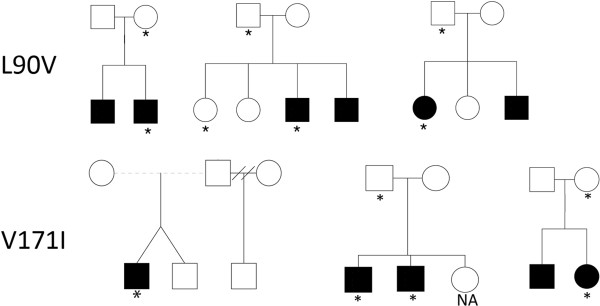
Pedigree structure of ASD families harboring the Leu90Val or Val171Ile variants. Subjects harboring either variant are indicated by an asterisk. Individuals for whom DNA was not available are labeled NA. Individuals with ASD are indicated by filled circles or squares, while unfilled elements reflect individuals without an ASD diagnosis.